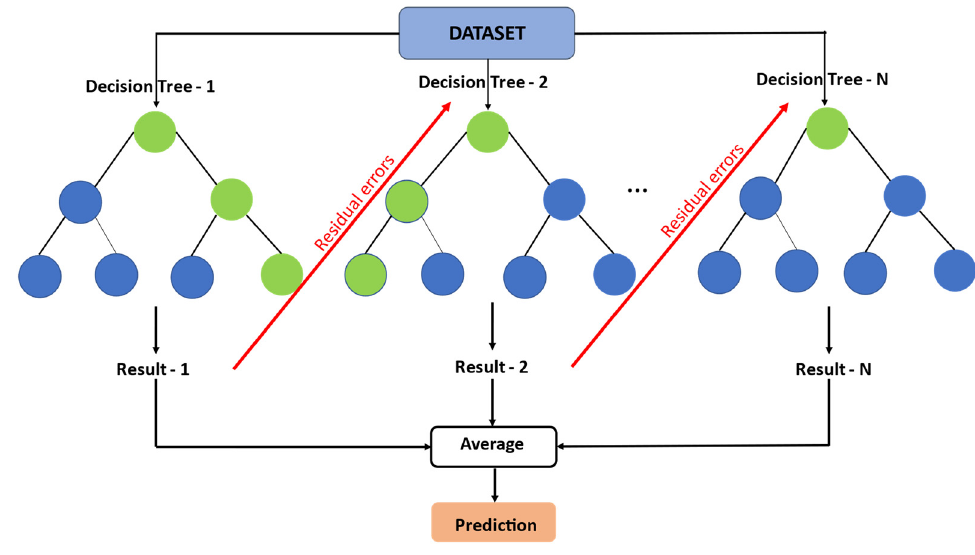
Figure 3. Structure of an XGBoost algorithm for regression.